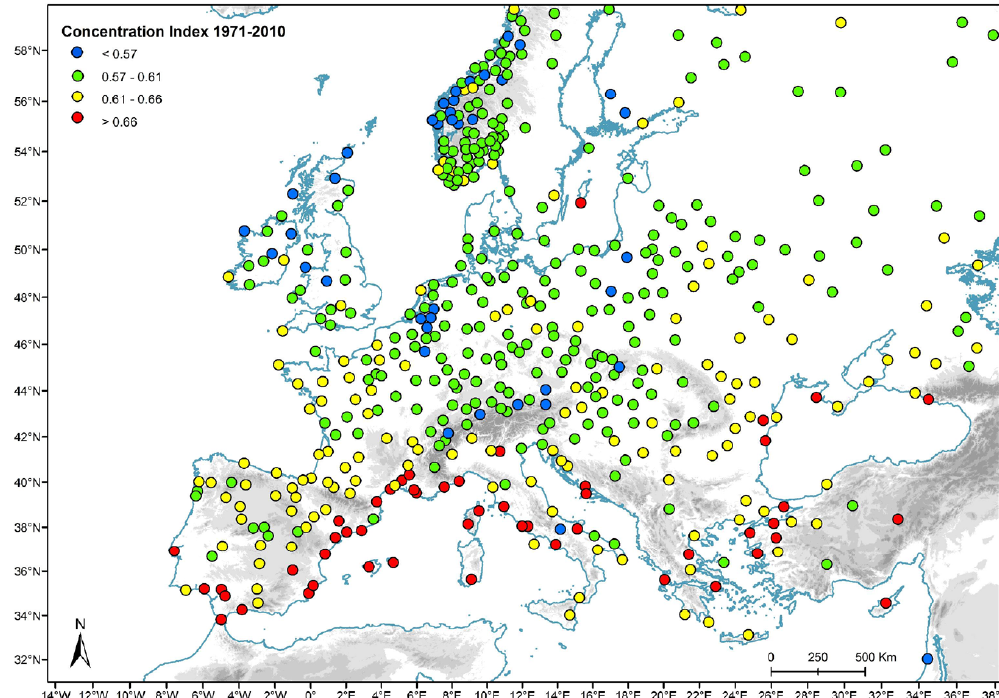
Fig. 6. Summer CI values distribution. Each colour corresponds to a different interval: CI values 0.56 or lower (blue dots), between 0.57 and 0.61 (green dots), between 0.62 and 0.66 (yellow dots), and 0.67 or higher (red dots).